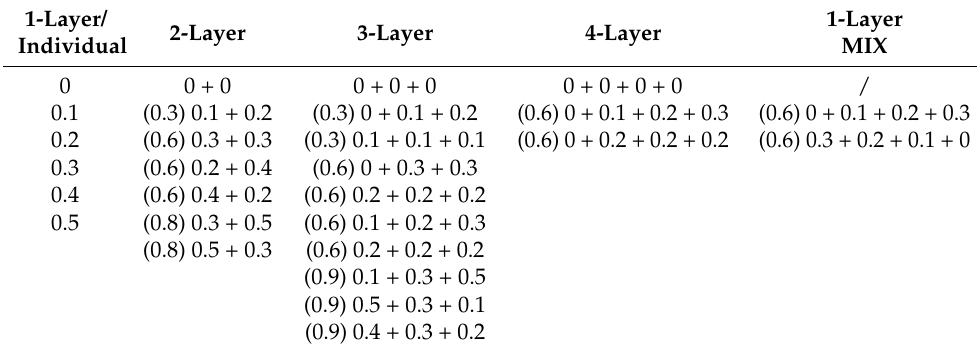
Table 1. The list of viscous (VIS) fibre membranes used in the study and tested either as an individual (mono-layer) or sandwich (multi-layer) membranes. Each fibrous layer of approx. 0.43 g (or indi- vidual VIS slivers in the case of the 1-layer mixture/MIX) was impregnated with (in total) 50 mL of 0.1 wt% (i.e., 50 mg) quaternised cellulose nanofibrils (qCNF) without (0%), or with, the